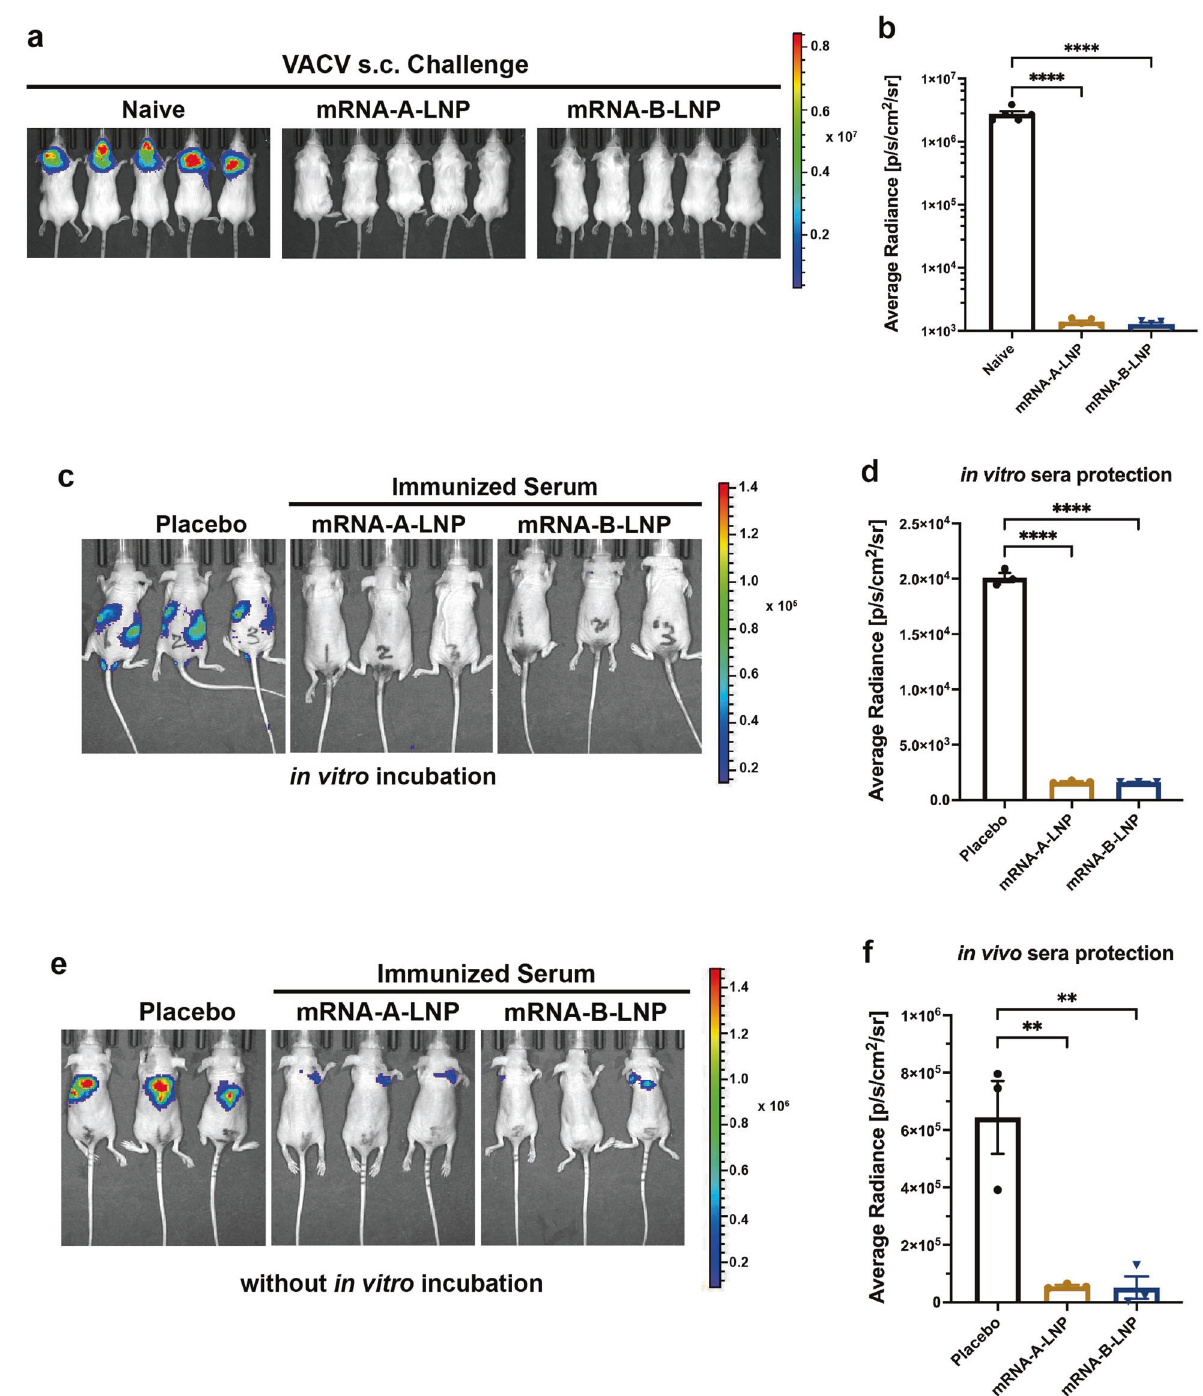
Fig. 4 Protection of mRNA-A-LNP and mRNA-B-LNP against VACV Challenge in Mice. a , b Thirty days after initial immunization, mice ( n = 5) were s.c. challenged with VACV (4 × 10 5 TCID 50 ). The viral load of mice was measured by bioluminescence imaging, and the bioluminescence signal of mice was measured 24 h after the challenge. c , d In vitro serum protection. Serum (13 μ l) and virus (4 × 10 3 TCID 50 ) were mixed for 1 h before the i.v. and i.p. challenges of the 4-week-old nude mice ( n = 3). Bioluminescent signal measurements were taken 6 h after the viral challenge. e , f In vivo serum protection. Serum (50 μ l) was fi rst injected intravenously into the 4-week-old nude mice ( n = 3), followed 1 h later by s.c. challenge with VACV (2.5 × 10 5 TCID 50 ). Bioluminescent signal measurements were taken 24 h after the viral challenge. Data are shown as mean ± SEM. Signi fi cance was calculated using one-way ANOVA with multiple comparison tests (** p < 0.01, **** p <